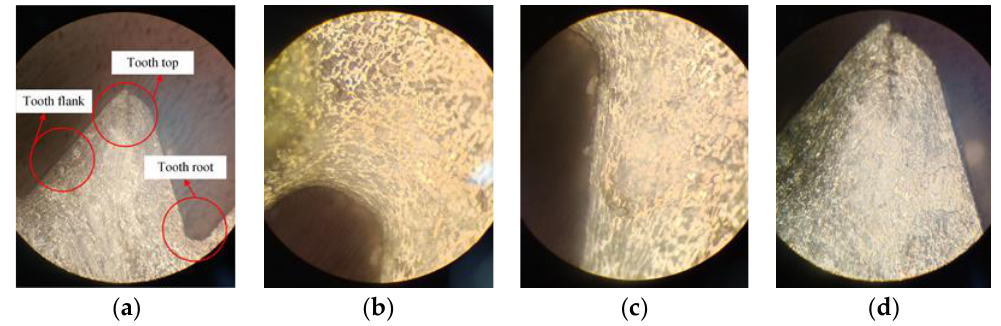
Figure 11. Extrusion profile measurement: ( a ) Three measurement positions, ( b ) Tooth root, ( c ) Flank, and ( d ) Tooth top.